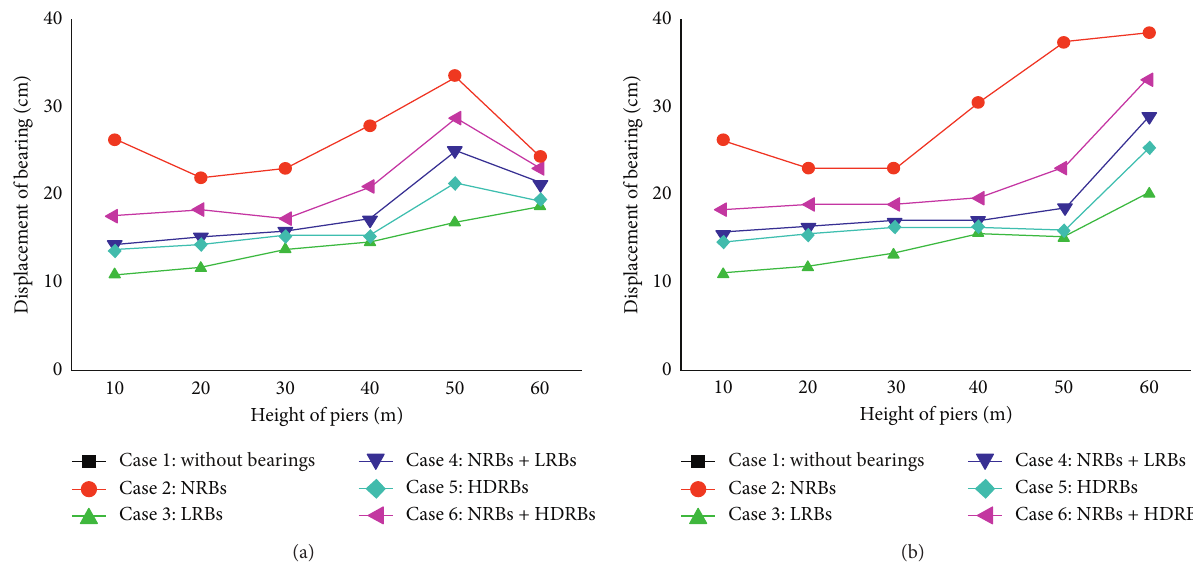
Figure 16: Displacement of bearings with the change of pier height in different cases: (a) longitudinal; (b)